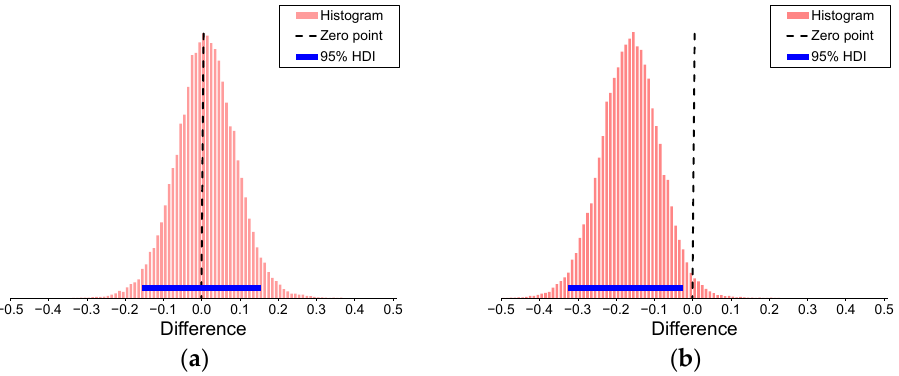
Figure 10. The example histograms of the differences obtained from two ( a ) similar and ( b ) different distributions.